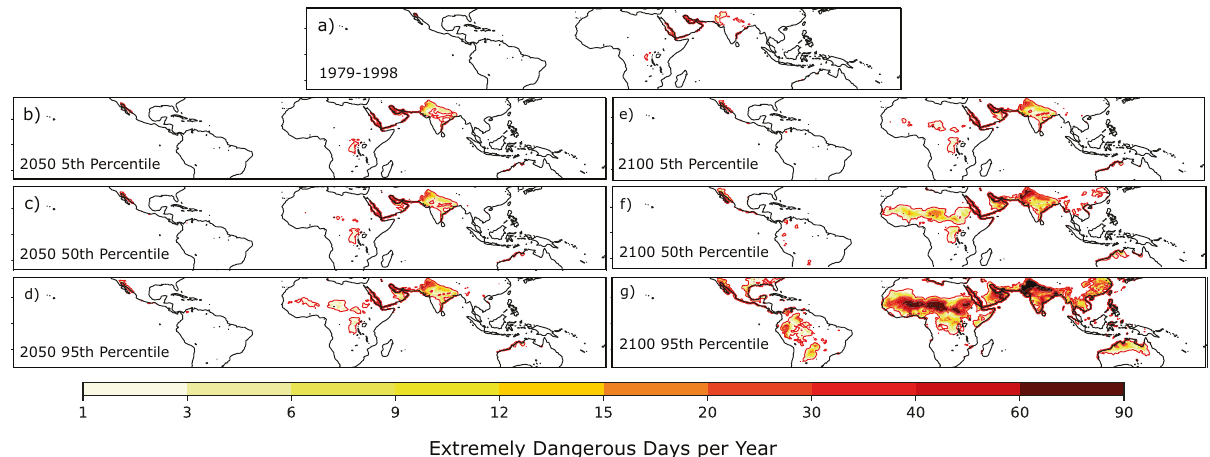
Fig. 4 Projections of extremely dangerous Heat Index values. Same as Fig. 3a – g but for exceedances of the extremely dangerous Heat Index threshold. Red contours in all panels outline regions where the extremely dangerous Heat Index threshold is exceeded more than once per year on